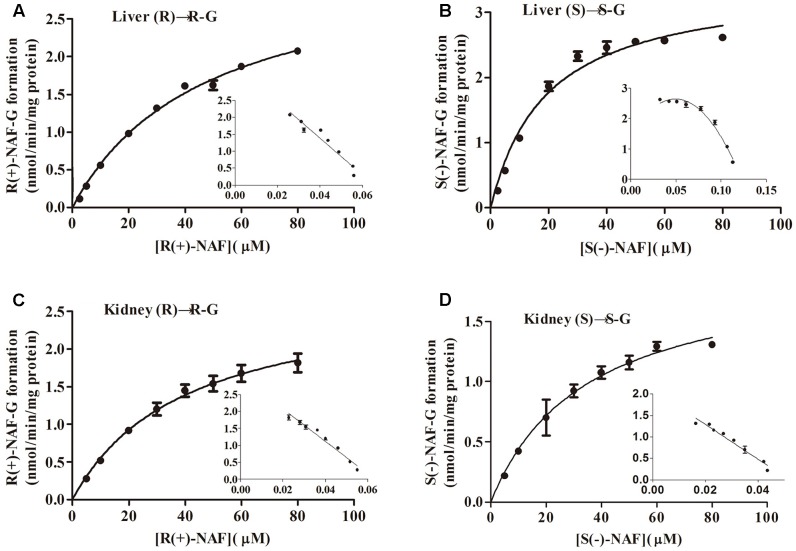
Kinetic analysis of naftopidil enantiomers conversion into their respective glucuronide conjugates by microsomes from human liver and kidney. Human liver microsomes were incubated with R(+)-NAF (A) and S(–)-NAF (B). Human kidney microsomes were incubated with R(+)-NAF (C) and S(–)-NAF (D). For each panel, large graphs represent the Michaelis–Menten plots, while small graphs correspond to the Eadie–Hofstee plots in triplicates.